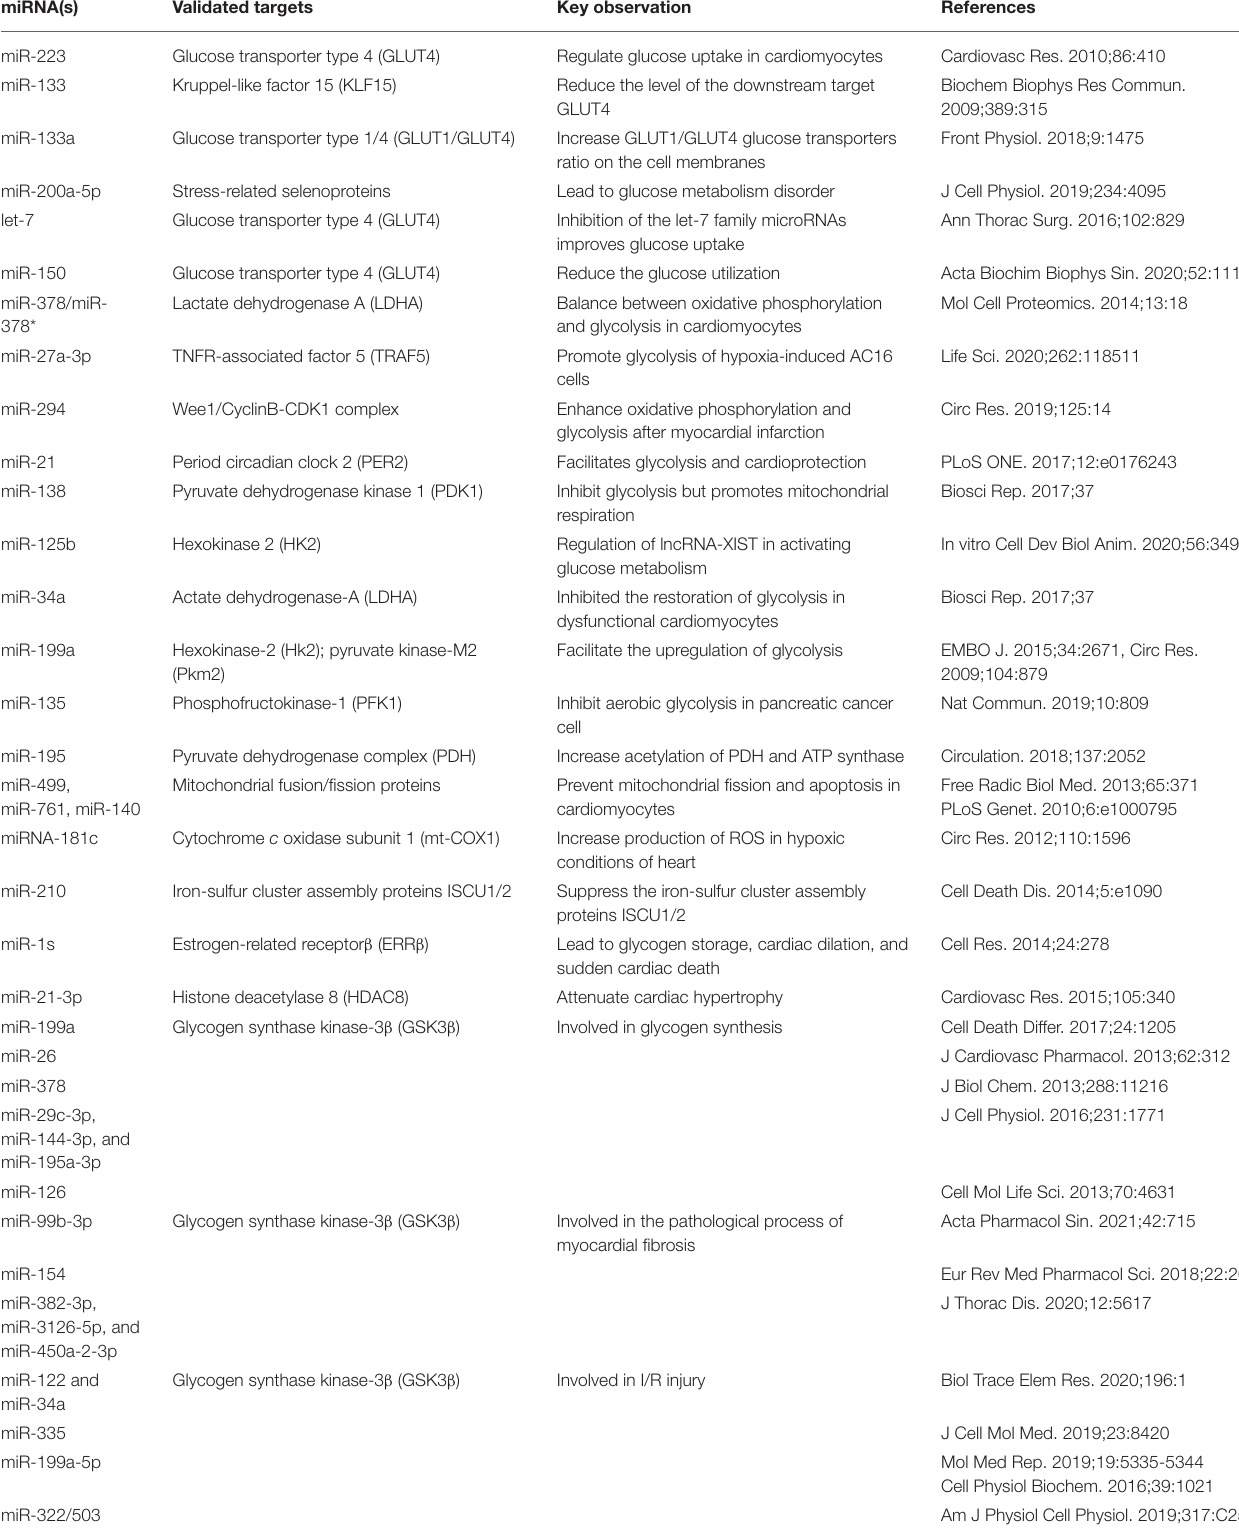
TABLE 1 | Roles of microRNAs in the glucose and lipid metabolism in the heart.